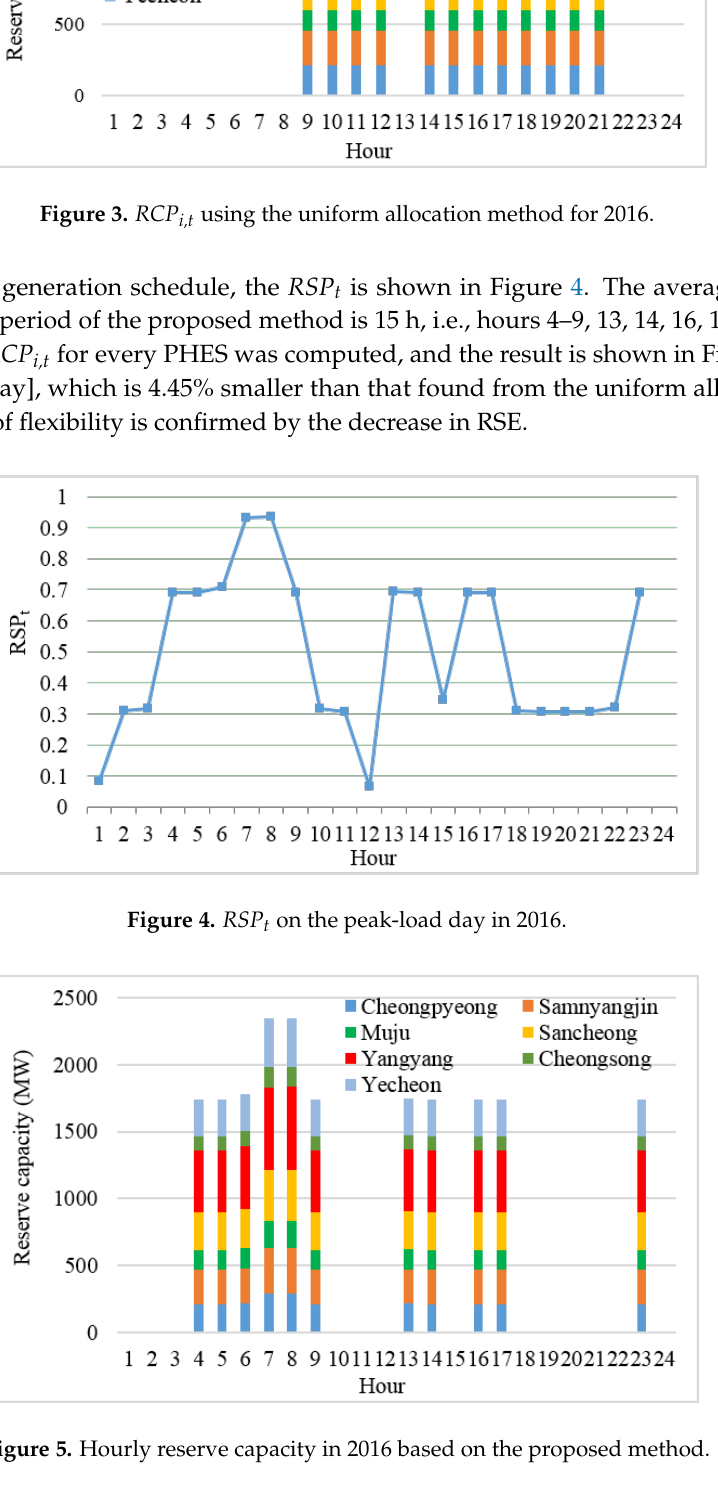
Figure 5. Hourly reserve capacity in 2016 based on the proposed method.